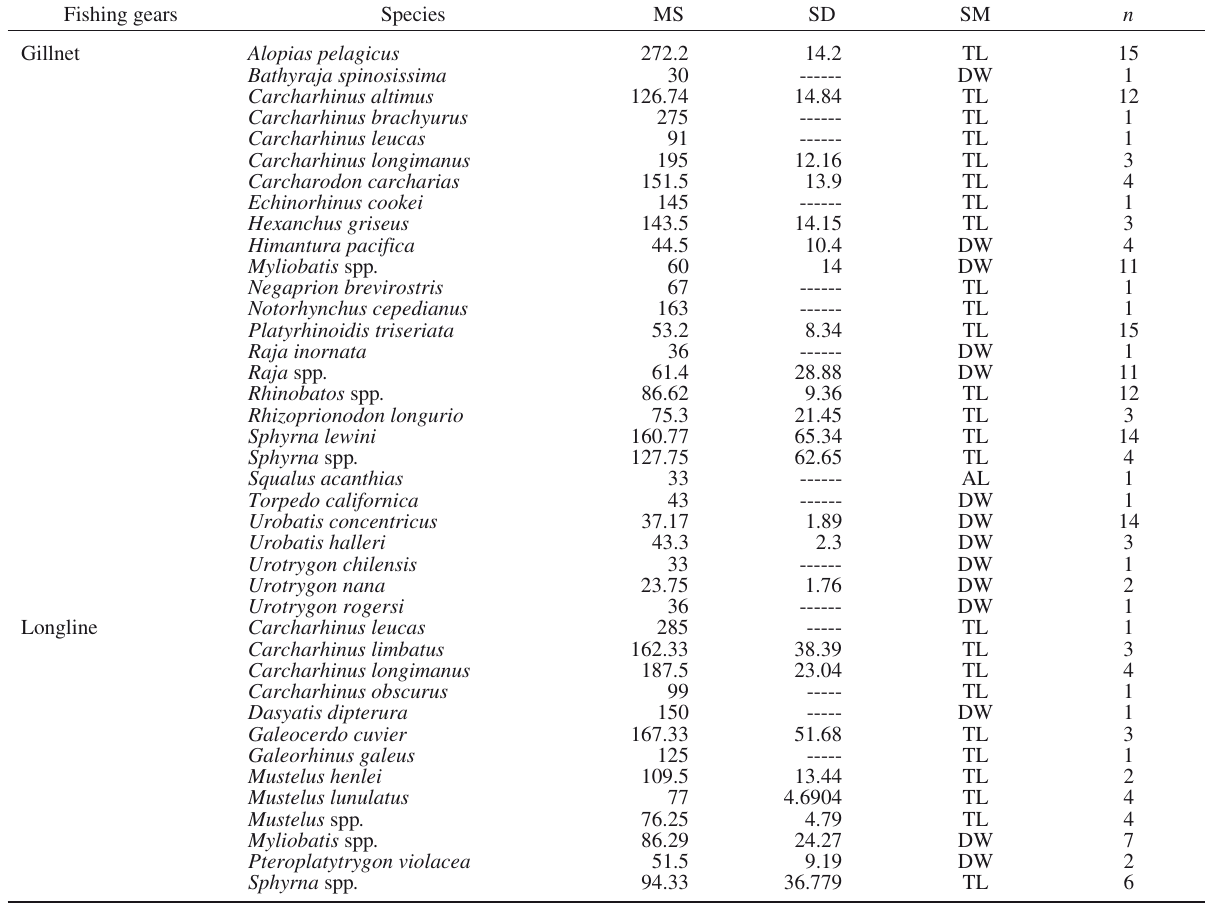
Table 7. – Summary statistics on size parameters for elasmobranch species captured by gillnet (where n <16) and longline (where n <8). Mean size (MS, in cm) ± standard deviation (SD) is shown for each specified measurement (SM). TL, total length; DW, disc width; AL, alternate length. Fishing